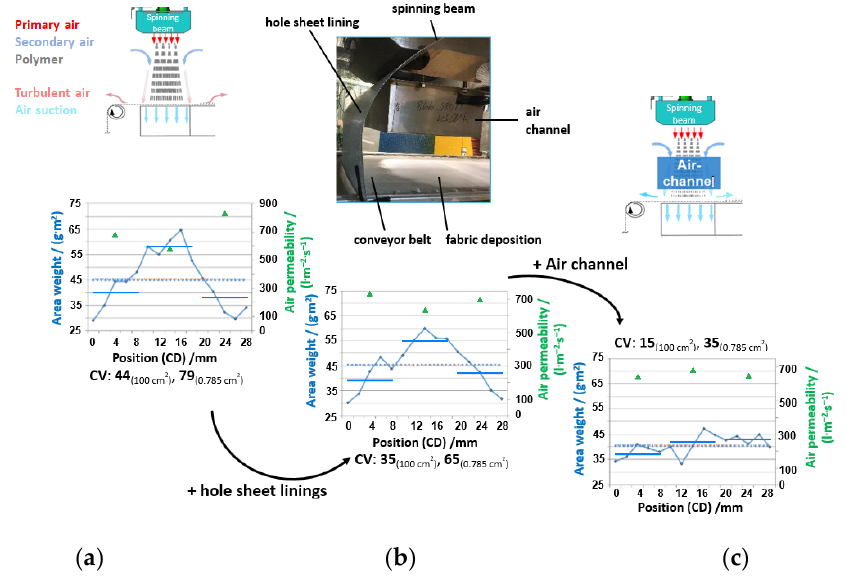
Figure 14. Fabric homogeneity along CD, characterized by area weight (sampling size 0.785 cm 2 (14 measurement points: blue dots) and 100 cm 2 (3 measurement points: blue lines)) and air permeability (three positions: green triangles) for spinning PP HL712FB at constant spinning conditions: ( a ) without add-on; ( b ) with addition of a hole shine lining to the space between spinning beam and deposition belt; ( c ) for addition of the air channel (200 mm length, distance 50 mm) between spinning beam and deposition belt.